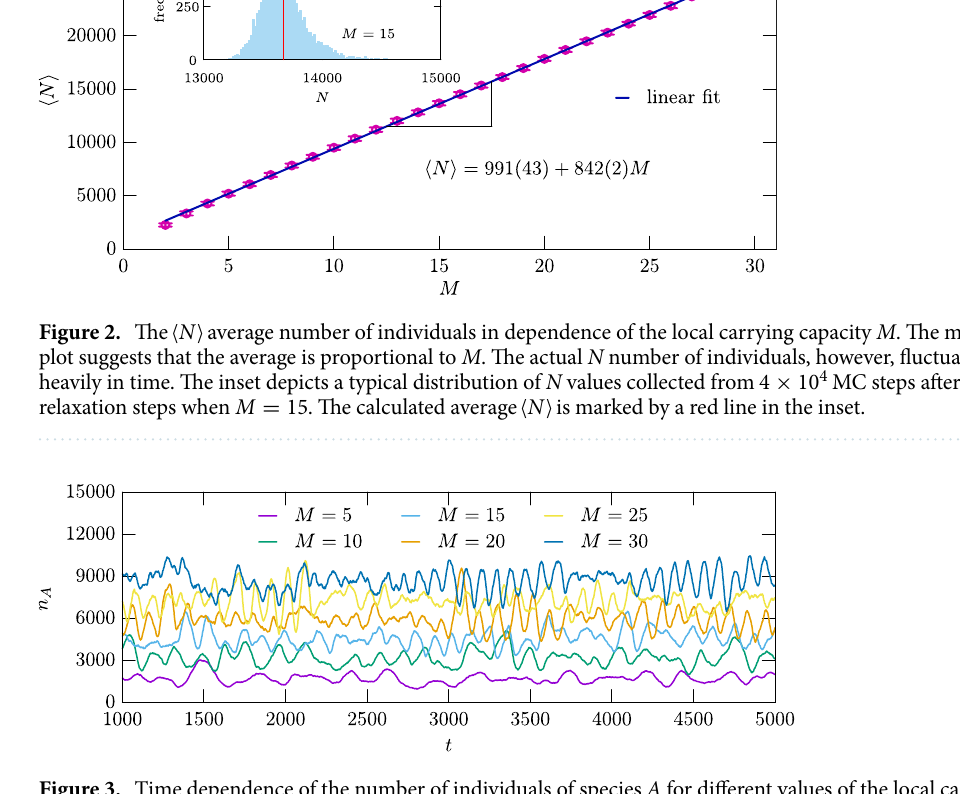
Figure 3. Time dependence of the number of individuals of species A for different values of the local carrying capacity. The applied M values are shown in the legend. These lines suggest that the oscillation becomes pronounced for higher M values. This behavior agrees with the one we observed in Fig. 1, indicating the emergency of rotating spirals and waves. Naturally, similar patterns can be detected for the remaining two species because of the symmetry of the